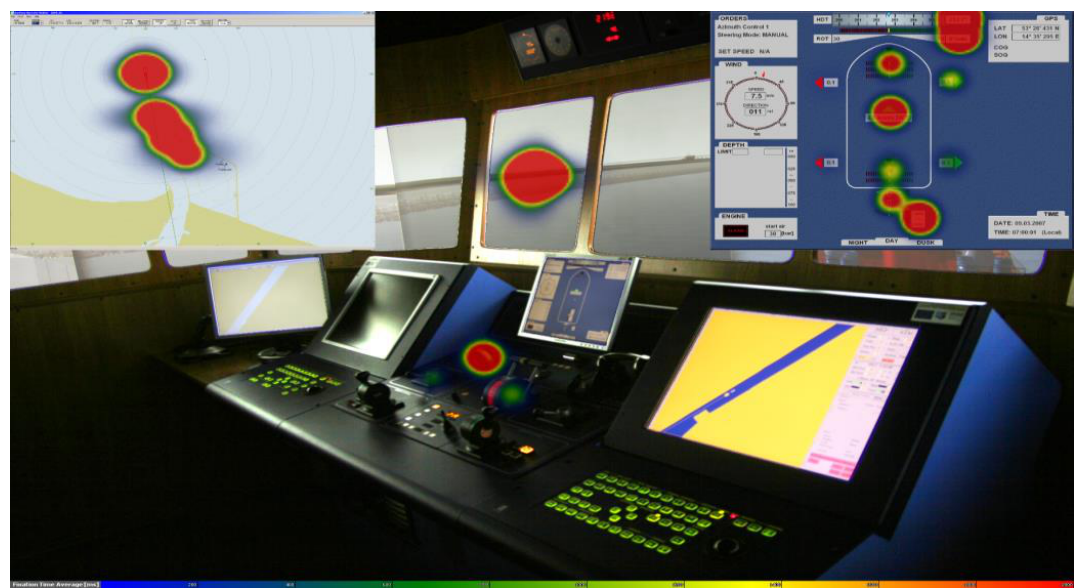
Figure 7. Heat map fixation time distributions: a gas tanker passage in a restricted area.